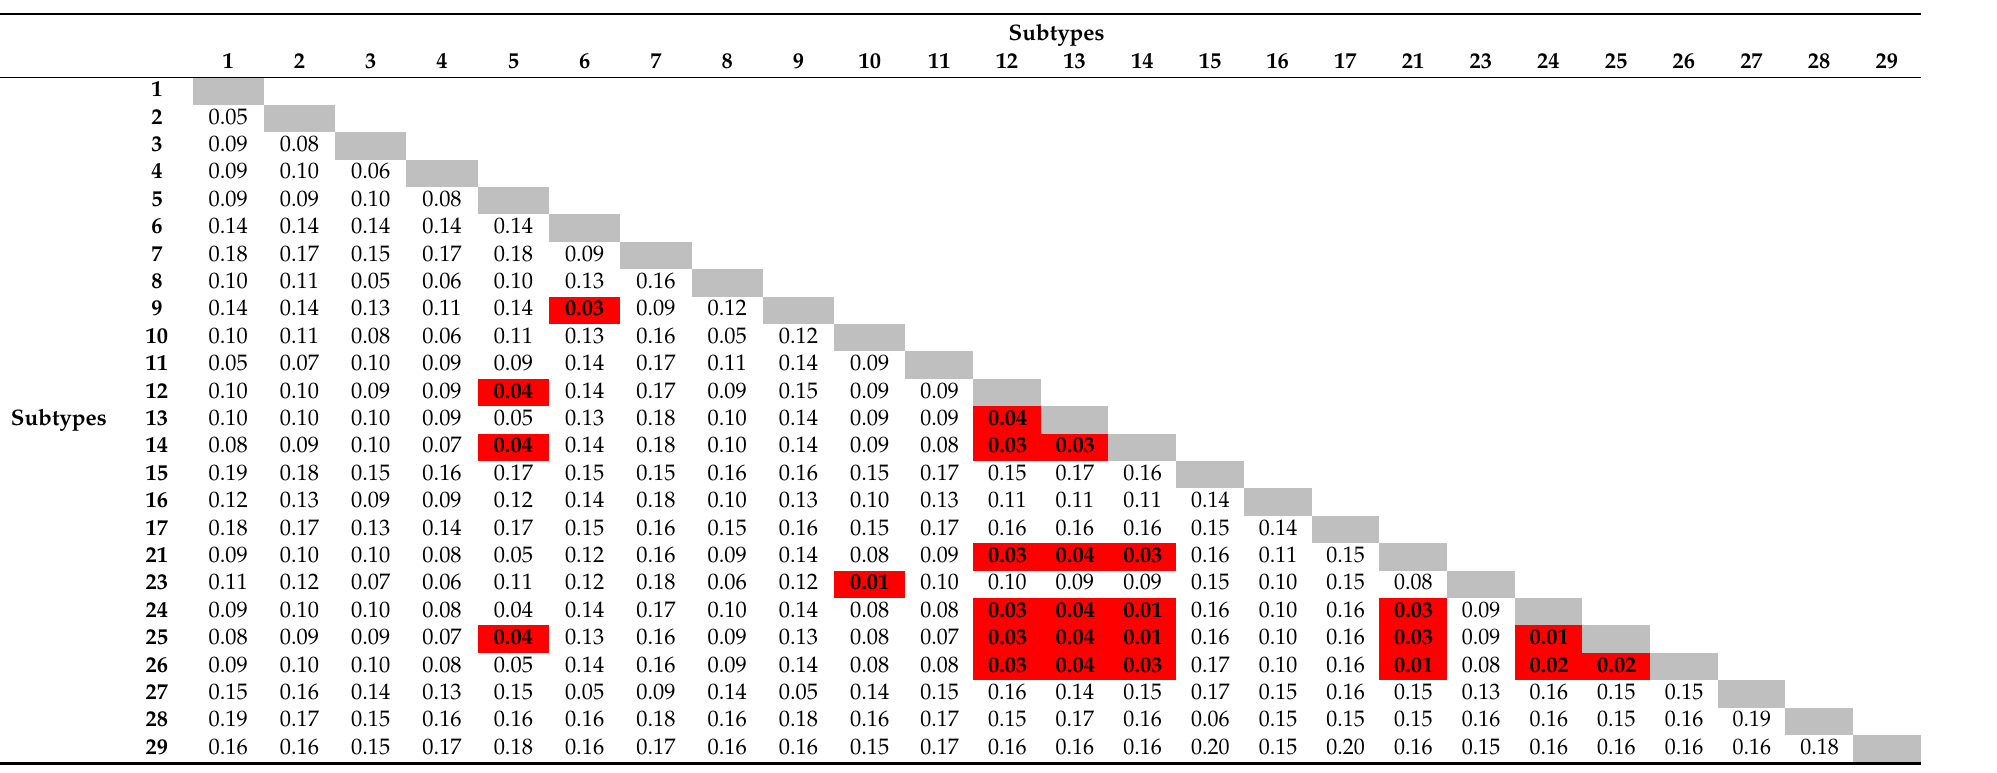
Table 4. Pairwise distances between Blastocystis subtypes barcoding region sequences showing the average number of base substitutions per site. Analyses were conducted using the Kimura 2-parameter model and included 64 nucleotide sequences (Table 2). There were a total of 587 positions in the final dataset. Red background indicates pairwise distance lower than